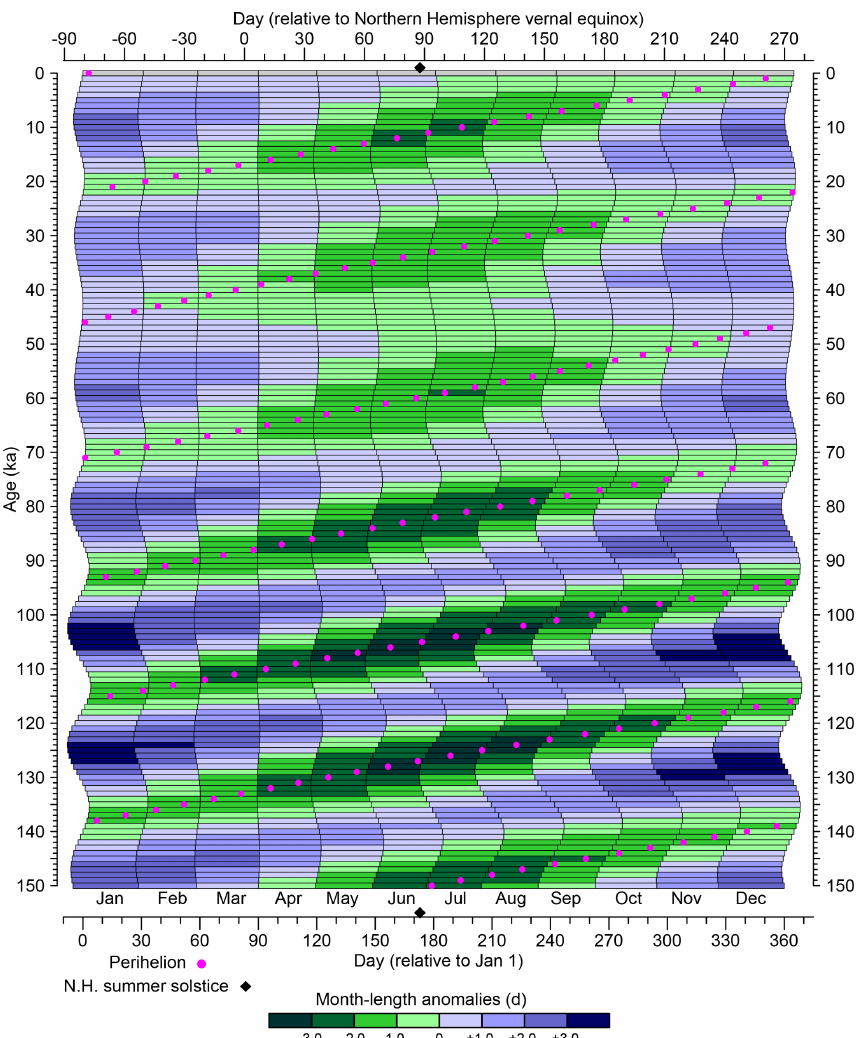
Figure 1. Variations over the past 150kyr in the beginning and ending days of fixed-angular months for a 365d noleap calendar, shown for 1kyr intervals beginning at 0ka (1950 CE). The left side of each horizontal bar shows the beginning day, while the right side shows the ending day of a particular month for each 1kyr interval. The month-length “anomalies” or differences from the present day are shown by shading, with individual paleo months that are shorter than those at present indicated by green shades and those that are longer indicated by blue shades. The day that perihelion occurs for each 1kyr interval is indicated by a magenta dot, and the overall pattern of month-length anomalies can be seen to follow the day of perihelion. The figure shows that the changing month lengths move the beginning, middle, and ending days of each month (as well as the beginning and ending days of the year). The day of the Northern Hemisphere summer solstice is indicated by a black diamond on the x